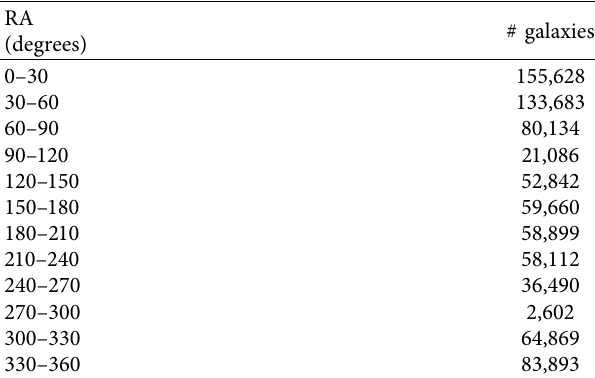
Table 1: The number of DECam galaxies in different 30 o RA slices.